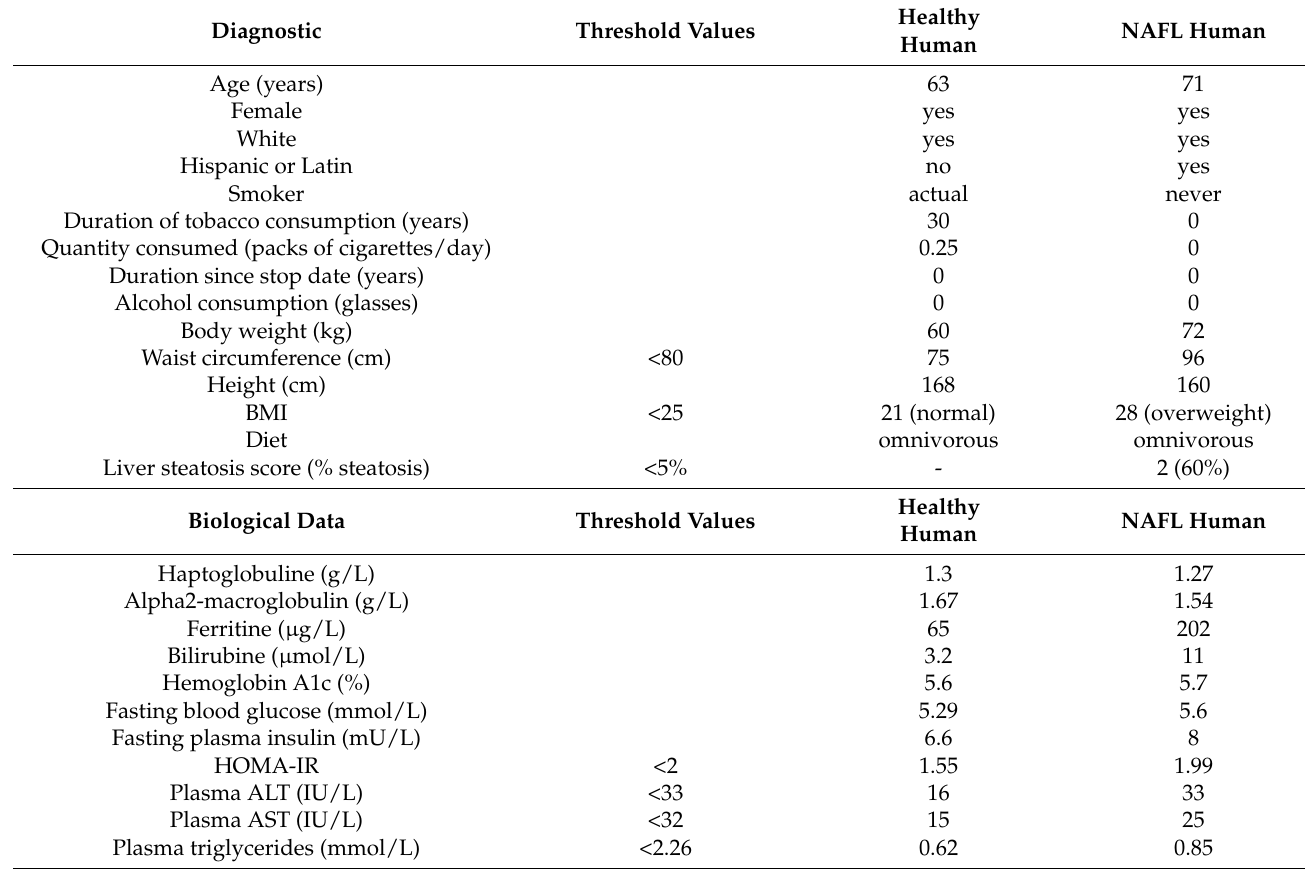
Table 1. Clinical design and selection. (a) Diagnostic data and (b) biological data for the non-alcoholic fatty liver (NAFL) patient and the healthy